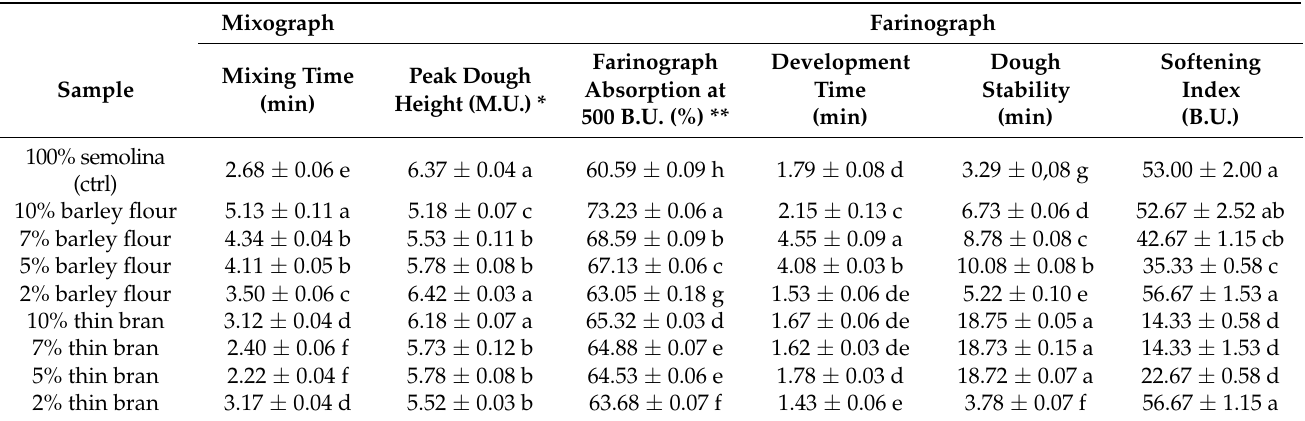
Table 4. Main technological parameters on semolina and flour inclusions: one-factor ANOVA (analysis of variance) (data are means ± standard